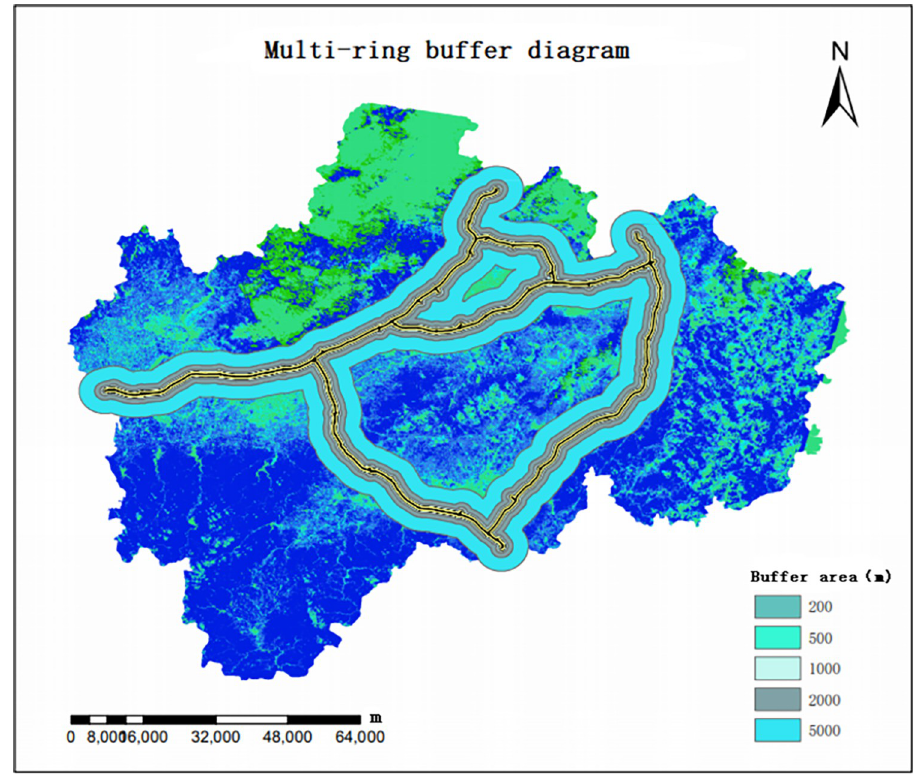
Fig 3. Diagram of buffer